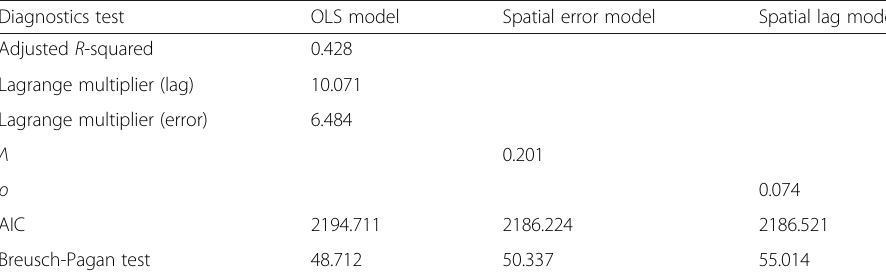
Table 4 Spatial dependence and diagnostic